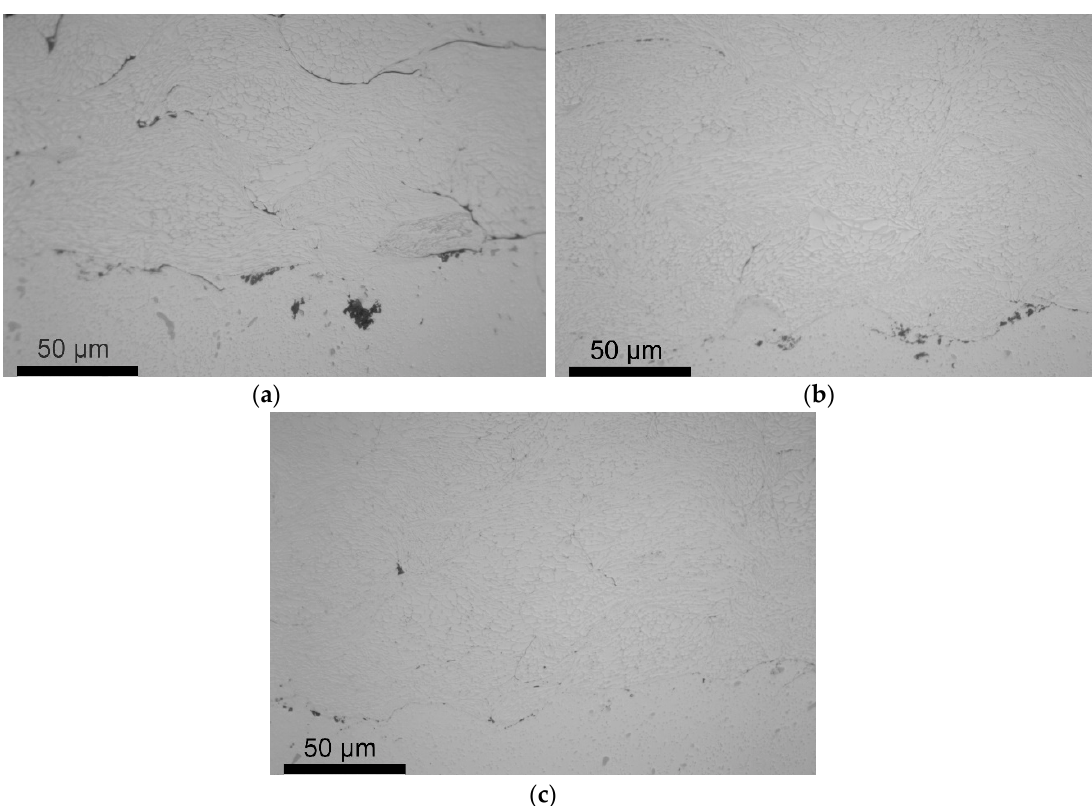
Figure 7. Structure and interface between CS Al6061 coating and Al substrate sprayed with different spray parameters ( a ) 30 bar, 400 ◦ C, ( b ) 35 bar, 400 ◦ C, and ( c ) 40 bar, 400 ◦ C. LM images.